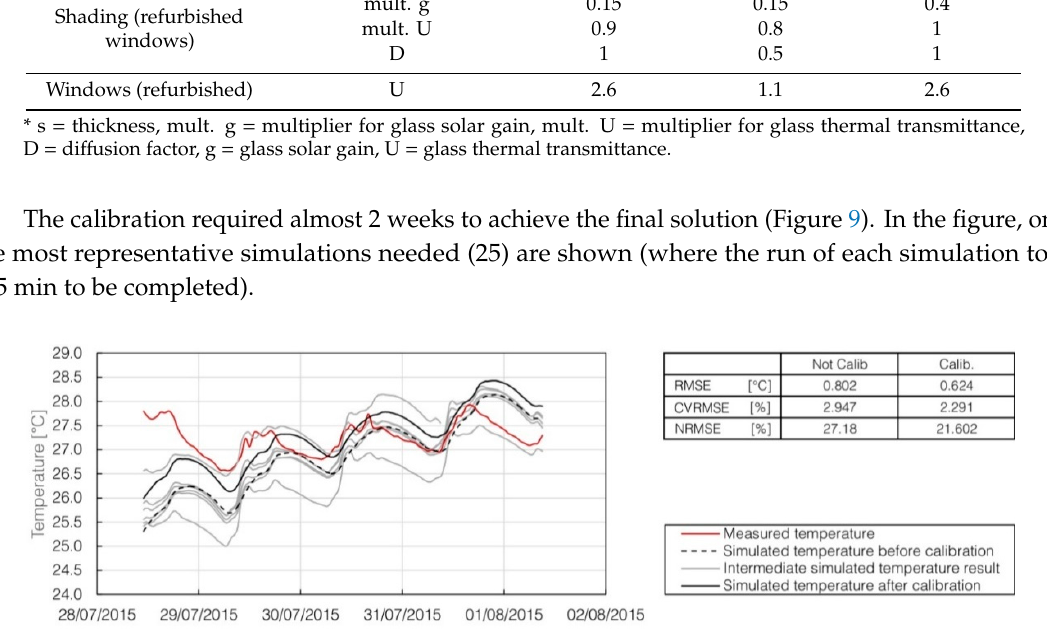
Figure 9. Results for Calibration B. Basement, South exposure.